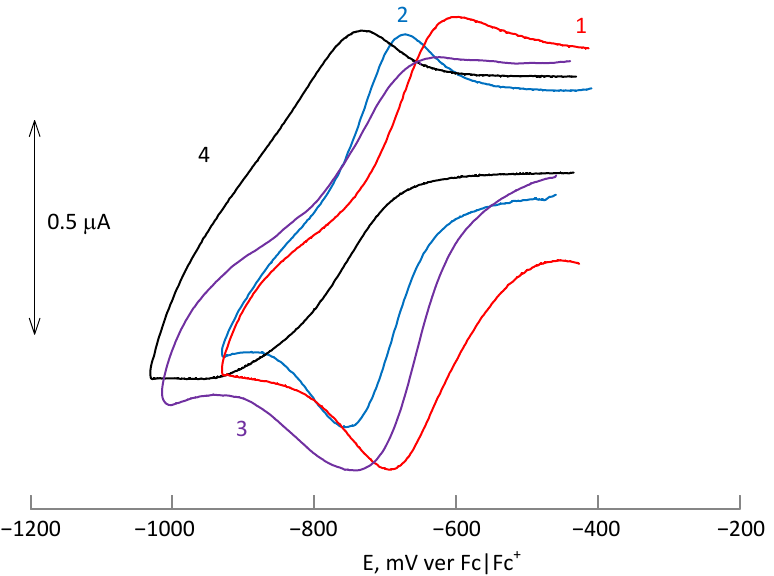
Figure 5. The CVA curves recorded in DMSO media at 25 °C. Supporting electrolyte—n-Bu 4 PF 6 (0.2 M). [CuBr 2 ] = 0.0045 M. [ligand] = 0.005 M. [RS] = 0.009 M. 1—CuBr 2 /PMDTA, Ep a = −610 mV. Ep c = −690 mV, E 1/2 = −650 mV; 2—CuBr 2 /TPMA, Ep a = −675 mV, Ep c = −755 mV, E 1/2 = −715 mV; 3—CuBr 2 /TPMA:CuBr 2 /PMDTA = 1:1, Ep a = −640 mV, Ep c = −740 mV, E 1/2 = −690 mV; 4—CuBr 2 + RS